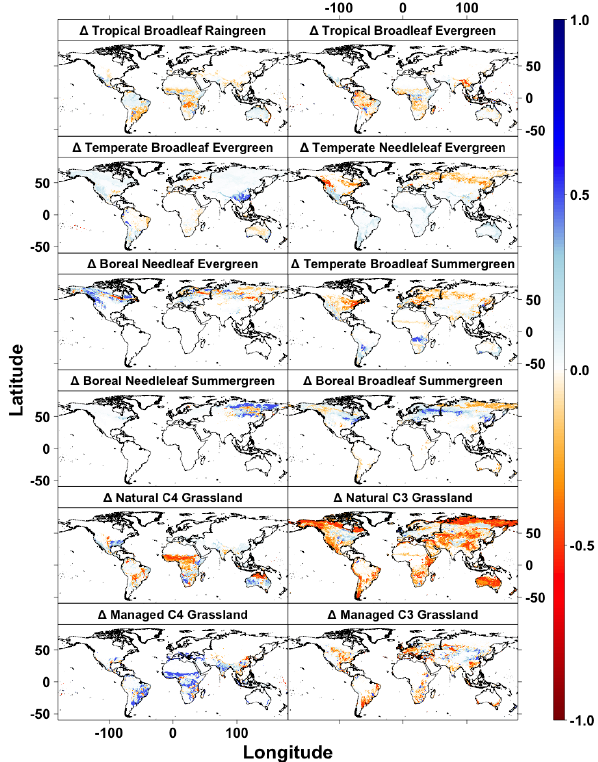
Figure 5. Difference in fractional coverage between the LC_CCI (epoch 2008–2012) and original ORCHIDEE PFT data set, based on Olson et al.